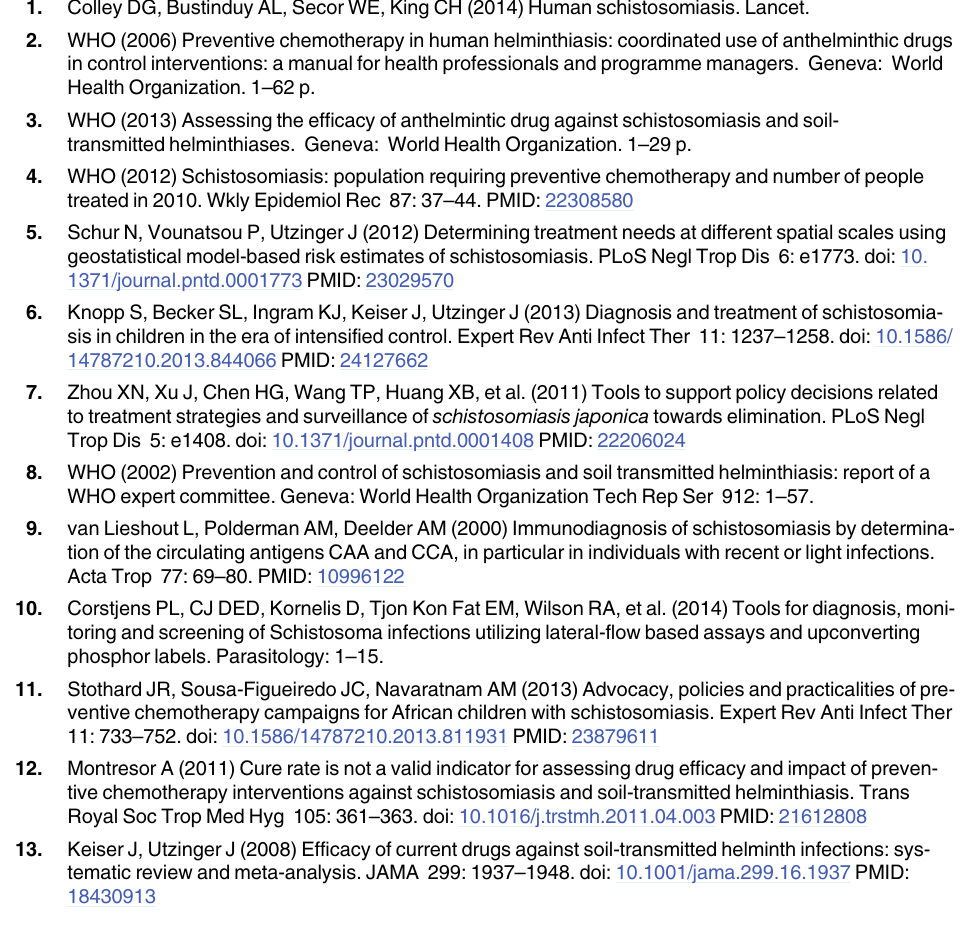
S3 Table. Frequencies and proportions of species by intensities of infection at baseline.